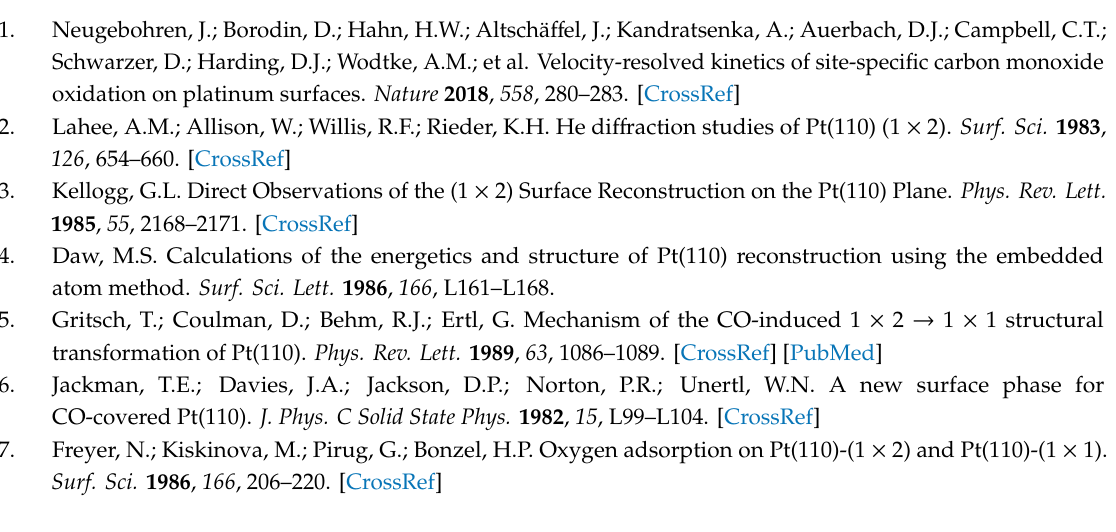
Figure S1: Apparent initial sticking probability s 0,app of oxygen at 420 K, Figure S2: He, Ar and O2 scattering from Pd(111) at 373, 573 and 873 K, respectively, Figure S3: Sticking probability of oxygen as a function of uptake for di ff erent sample temperatures, Figure S4: Simulated oxygen TPD spectra, Figure S5: Angle-resolved CO oxidation at 523 and 573 K surface